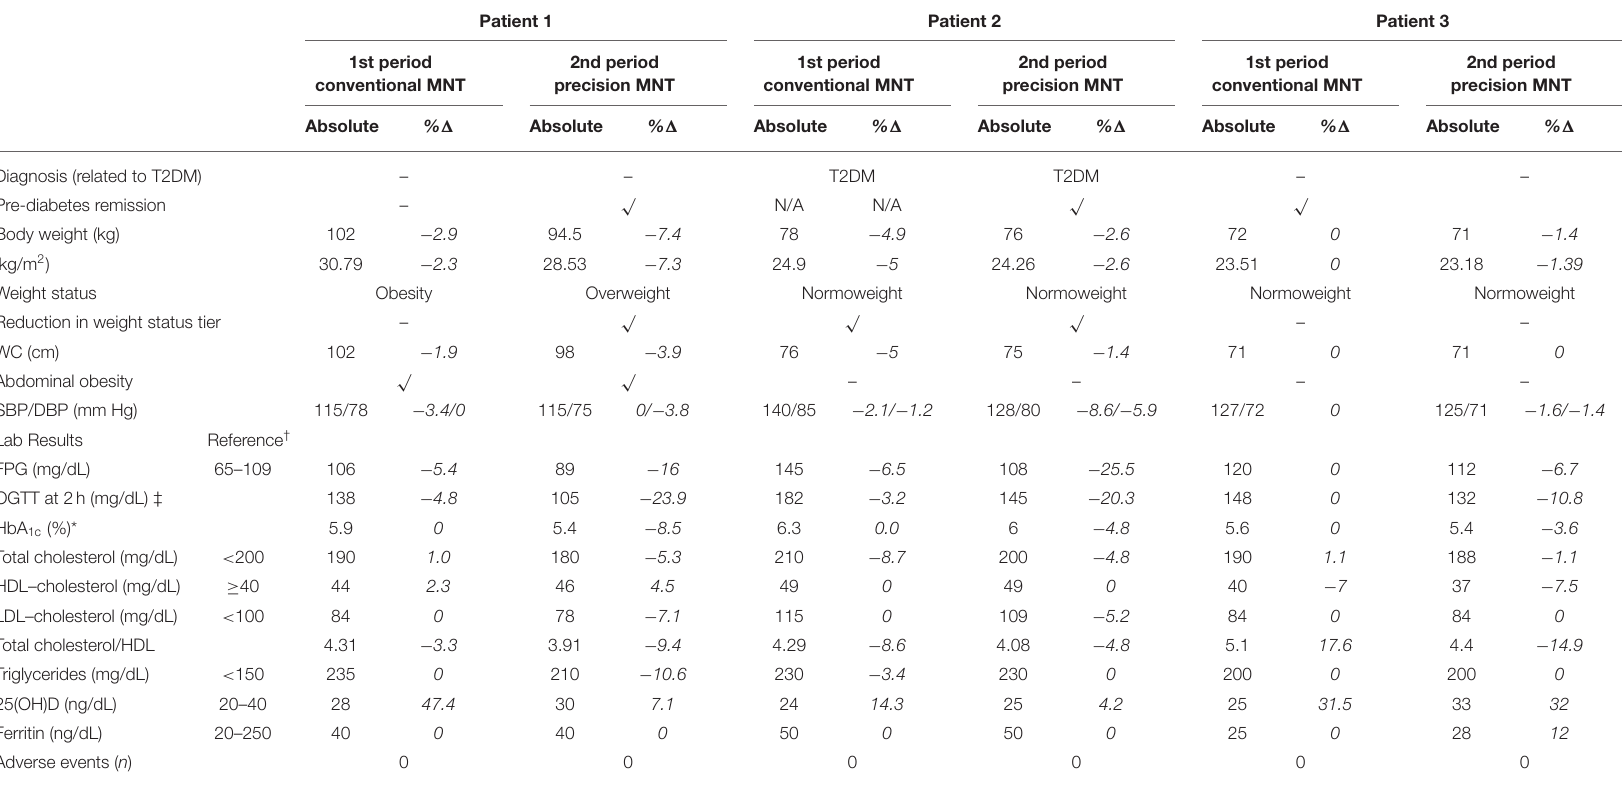
TABLE 4 | End-of-treatment results and % of change for each endpoint and cases after implementation of the conventional (1st) and precision (2nd) MNT intervention